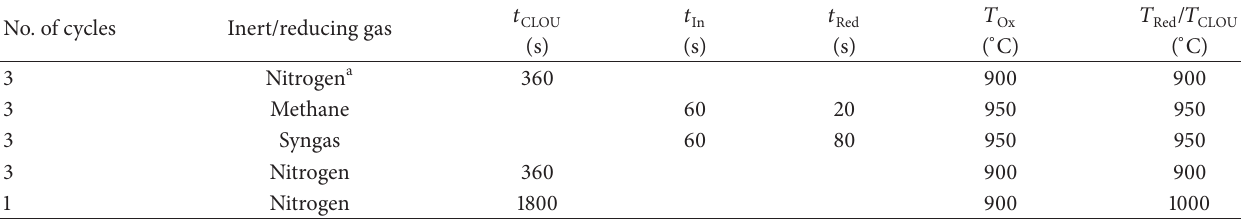
Table 2: Experimental scheme for oxygen carriers’ reactivity